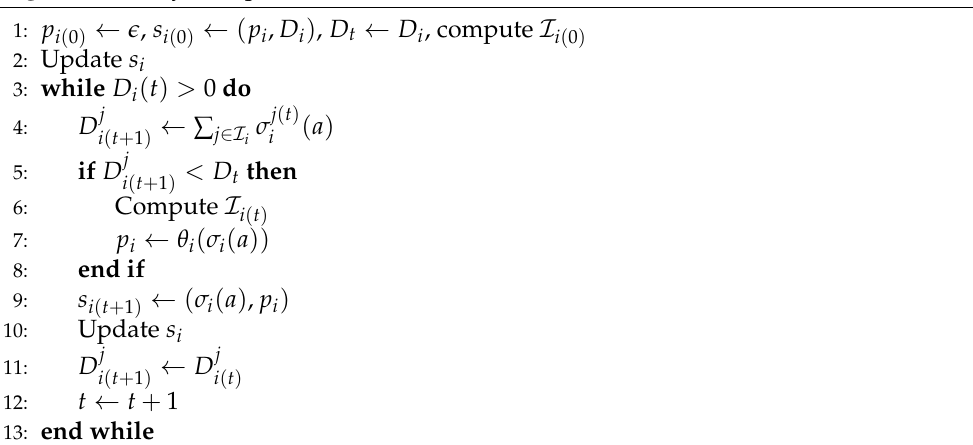
Algorithm 2 Buyer